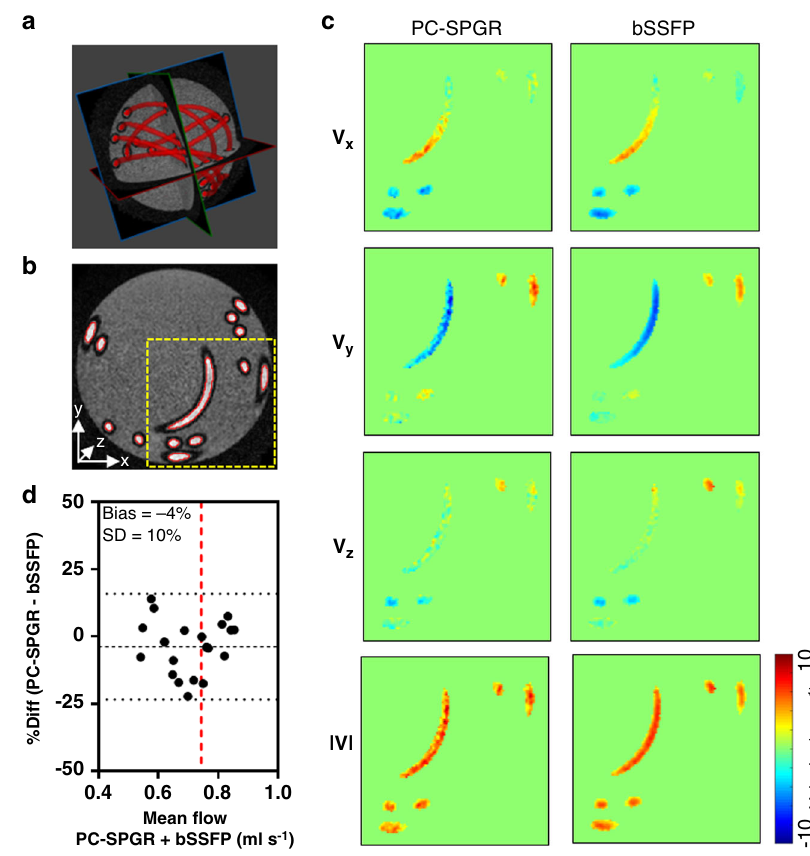
Fig. 2 Validation of multi-planar velocity encoding in a physical fl ow phantom. The physical fl ow phantom consisted of a spherical, water- fi lled glass fl ask containing a fi xed-diameter tube connected to a fl ow pump. a 3D render showing the segmented plastic tube in red. b Cross-sectional magnitude image where the dashed-yellow line corresponds to the velocity maps in part c of the fi gure. c Measured velocity components V x , V y , V z , and magnitude of the velocity |V| . Left column shows velocity components from the PC-SPGR acquisition. Right column shows velocity components from the bSSFP acquisition reconstructed using the proposed multi-stack velocity-encoding scheme. The mean (±SD) fl ow velocity across all voxels within the tube were 4.0±1.4cms − 1 (PC-SPGR) and 4.1±1.3cms − 1 (bSSFP). d Bland – Altman plot comparing mean fl ow values from ROIs ( n = 20 independent regions) within the fl ow phantom (Bias = − 4, SD of Bias = 10%). The red dashed line indicates the volume fl ow rate determined with a measuring cylinder. Source data are provided as a Source Data fi